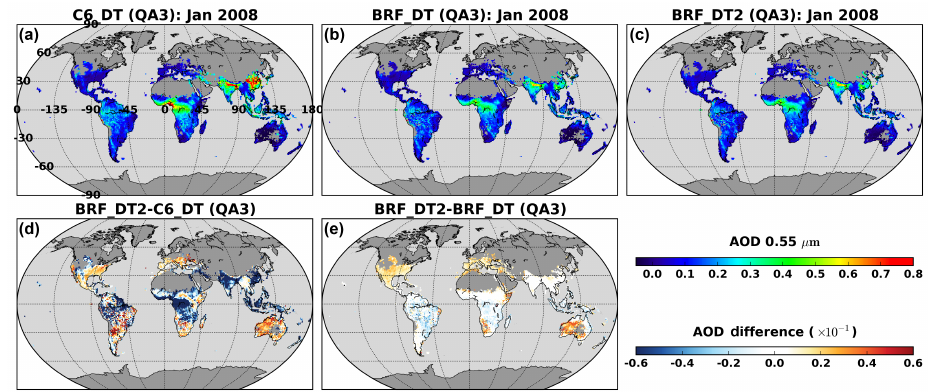
Figure 7. January 2008 maps (1 ◦ × 1 ◦ ) of mean AOD filtered with the best-quality QA = 3 (labeled as QA3) over global land. (a–c) show the AOD retrieved from C6_DT, BRF_DT and BRF_DT2, respectively. (d) and (e) show the AOD difference of BRF_DT2–C6_DT and BRF_DT2–BRF_DT,